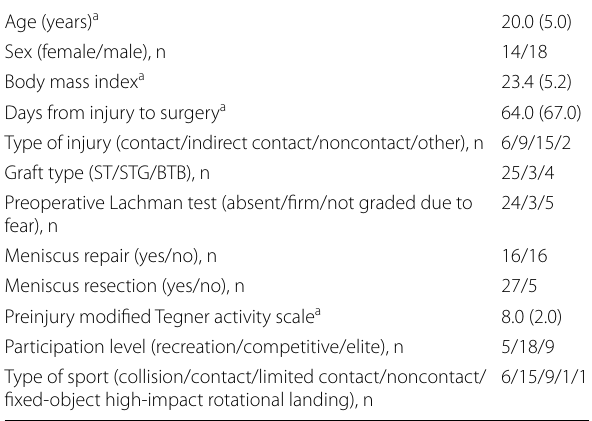
Table 1 Participants’ demographic characteristics